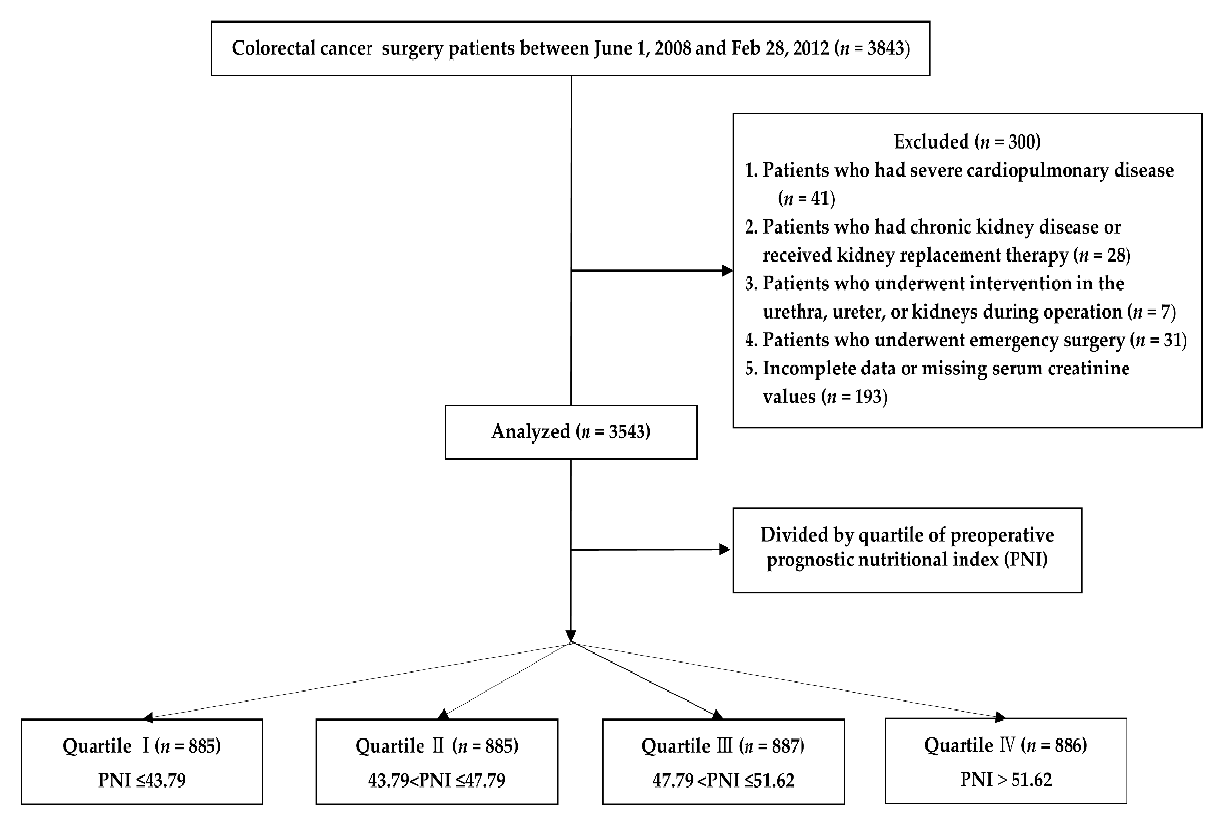
Figure 1. Study flow chart. Table 1. Demographic, perioperative variables, and surgical outcomes of study population.